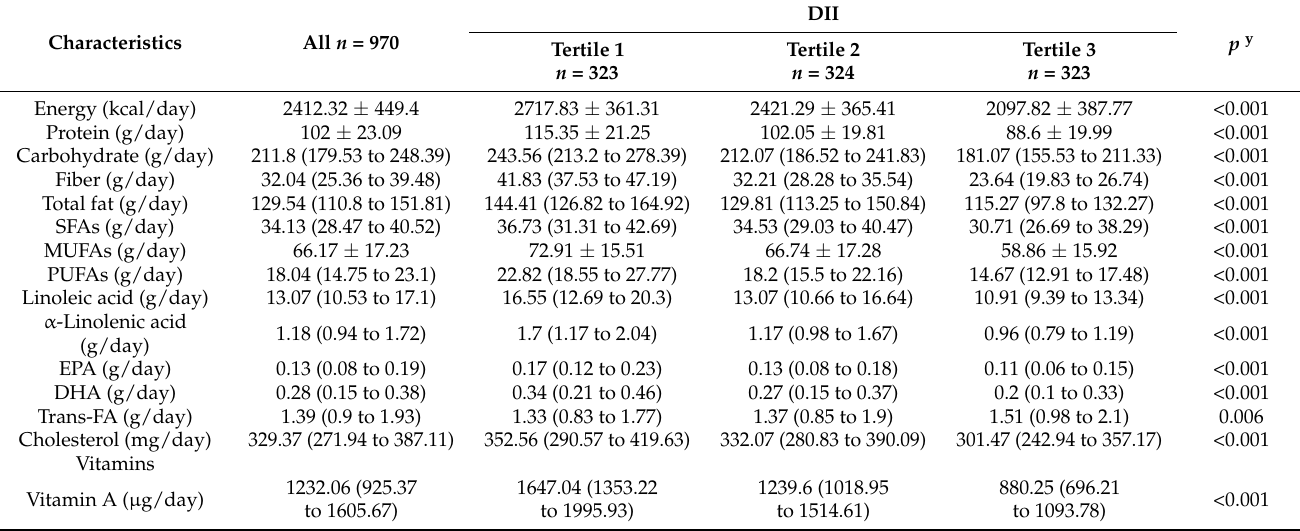
Table 3. Main dietary nutrient intake according to DII score tertiles ( n =